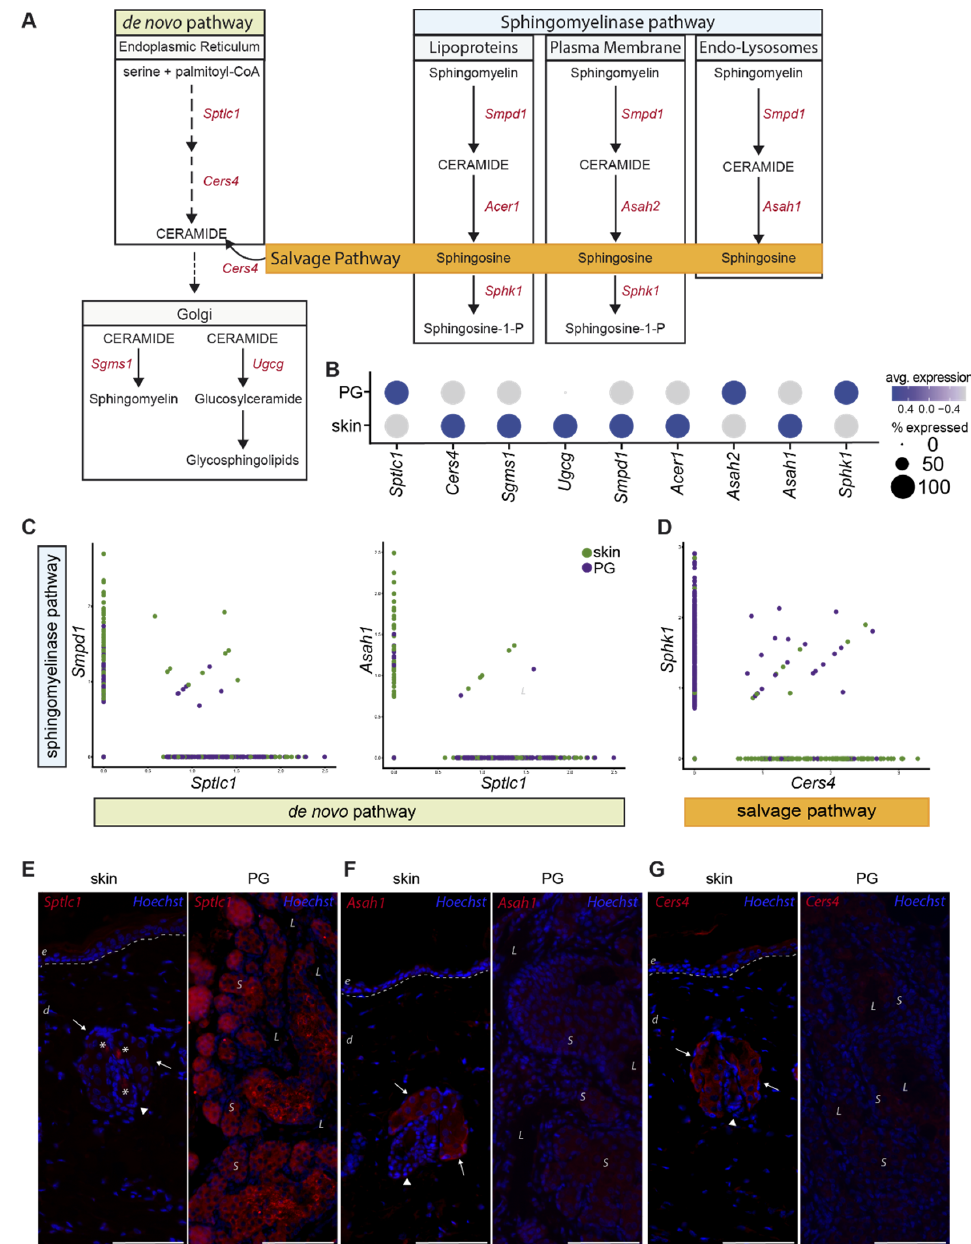
Figure 5. Preputial gland sebocytes are limited to de novo biosynthesis of sphingolipids. ( A ) Schematic drawing of the de novo, sphingomyelinase and salvage pathway of ceramide- and ceramide metabolite synthesis. Key enzymes involved in the respective pathways are colored in red. Sptlc1 : serine palmitoyltransferase1; Cers4 : ceramide synthase 4; Sgms1 : sphingomyelin synthase 1; Ugcg : ceramide glucosyltransferase; Smpd1 : sphingomyelinase 1; Acer1 : alkaline ceramidase; Asah2: neutral ceramidase; Asah1 : acid ceramidase; Sphk1 : sphingosine kinase 1. ( B ) Dot plot of average gene expression of the key enzymes involved in the synthesis of sphingolipids in preputial gland and skin tissue. Point size indicates relative averaged amount of positive cells. Color code indicates average gene expression levels. ( C ) Featurescatter-plot of sSEB and pSEB shows correlation gene expression of Smpd1 and Sptlc1 , or Asah1 and Sptlc1 . ( D ) Featurescatter-plot of sSEB and pSEB showing correlational gene expression of Sphk1 and Cers4 . Gene expression levels for each gene, respectively, is shown on either x- or y -axis. Immunofluorescent labeling of skin or preputial gland of ( E ) Sptlc1 , ( F ) Asah1 and ( G ) Cers4 . Scale bars = 100µm. Arrows indicate sebaceous glands in close proximity to hair shafts marked by arrowheads. Asteriscs in ( E ) left panel indicate staining of cell-free material; e: epidermis; d: dermis; L: lumen of the preputial gland; S: sebocytes.